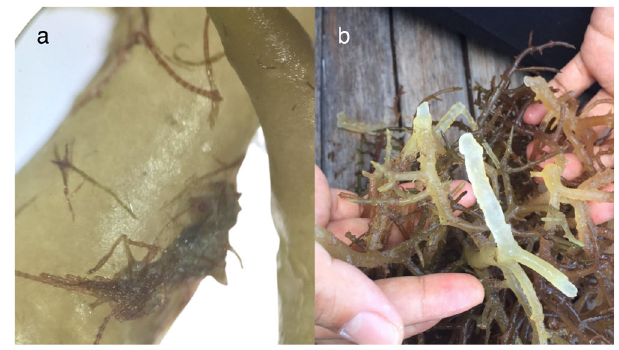
Fig. 1 | Examples of the diseases of red and brown seaweeds in aquaculture in Asia. a Epiphytic fi lamentous algae in Kappaphycus spp.; b Ice-Ice syndrome in Kappaphycus spp. Credit: Jennefe